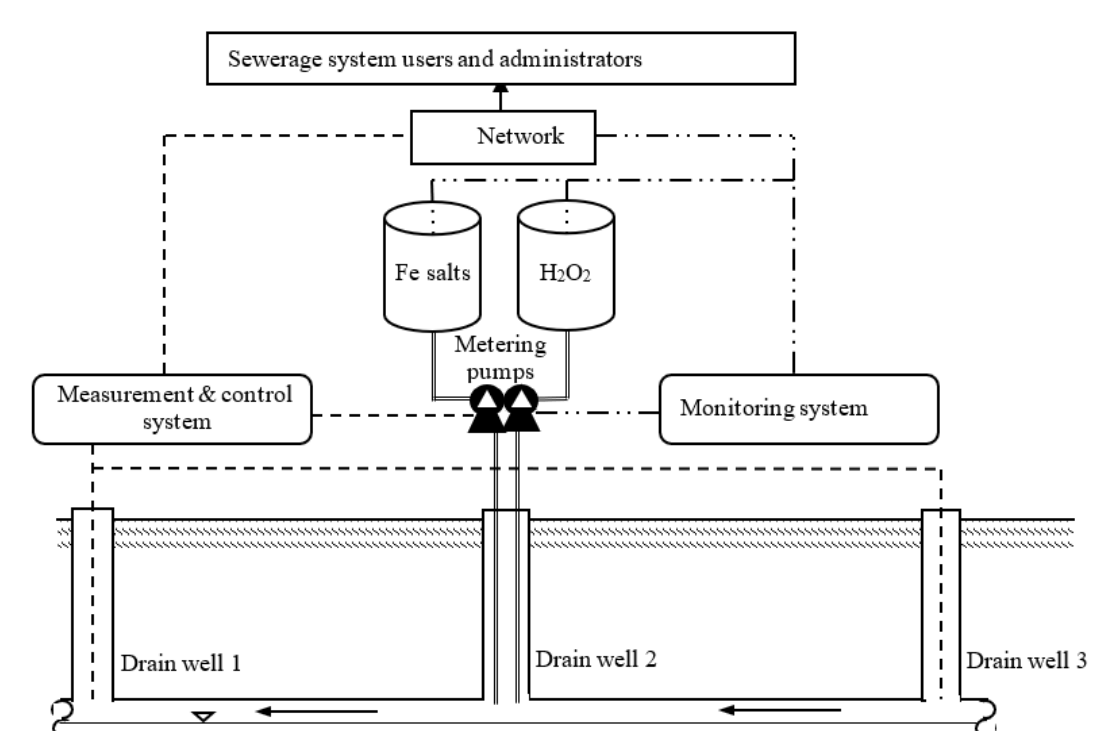
Figure 8. Diagram of the automatic reagent injection system for sewage networks.